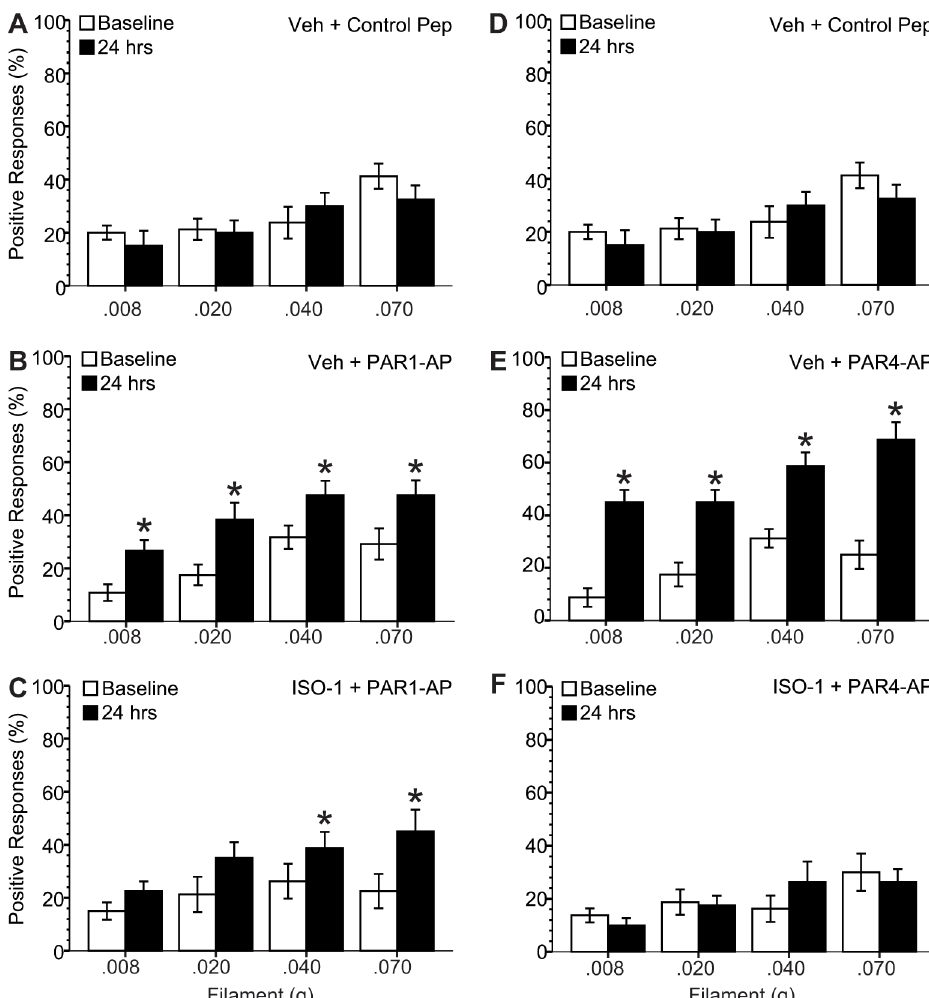
Fig 4. MIF mediates PAR1- or PAR4-induced mechanical hypersensitivity. Mechanical hypersensitivity was measured as % response out of 10 applications of von Frey monofilaments of graded stimulus strengths (as indicated) at baseline and 24 hour after one hour intravesical instillation of PAR-activating peptides. A ) Control group received pre-treatment with vehicle (20% DMSO in saline; i.p.) 15 minutes before intravesical instillation of a scrambled peptide. There was no statistical difference between baseline values and 24 hours after treatment. B ) Mice treated with intravesical PAR1-AP (and vehicle pre-treatment) showed a significant increase in the % response 24 hours after treatment at all filament strengths tested. C ) Pre-treatment with MIF antagonist (ISO-1; 20 mg/kg, 20% DMSO in saline; i.p.) 15 minutes before intravesical PAR1-AP instillation partially prevented the baseline vs. post- 24 hour increase in response seen after PAR1-AP alone. E ) Intravesical PAR4-AP instillation (vehicle pre-treatment) resulted in a significant increase in the % response at 24 hours when compared to baseline. F ) This effect was completely prevented by pre-treatment with ISO-1 (MIF antagonist). * p (cid:1) 0.05 when compared to the corresponding baseline